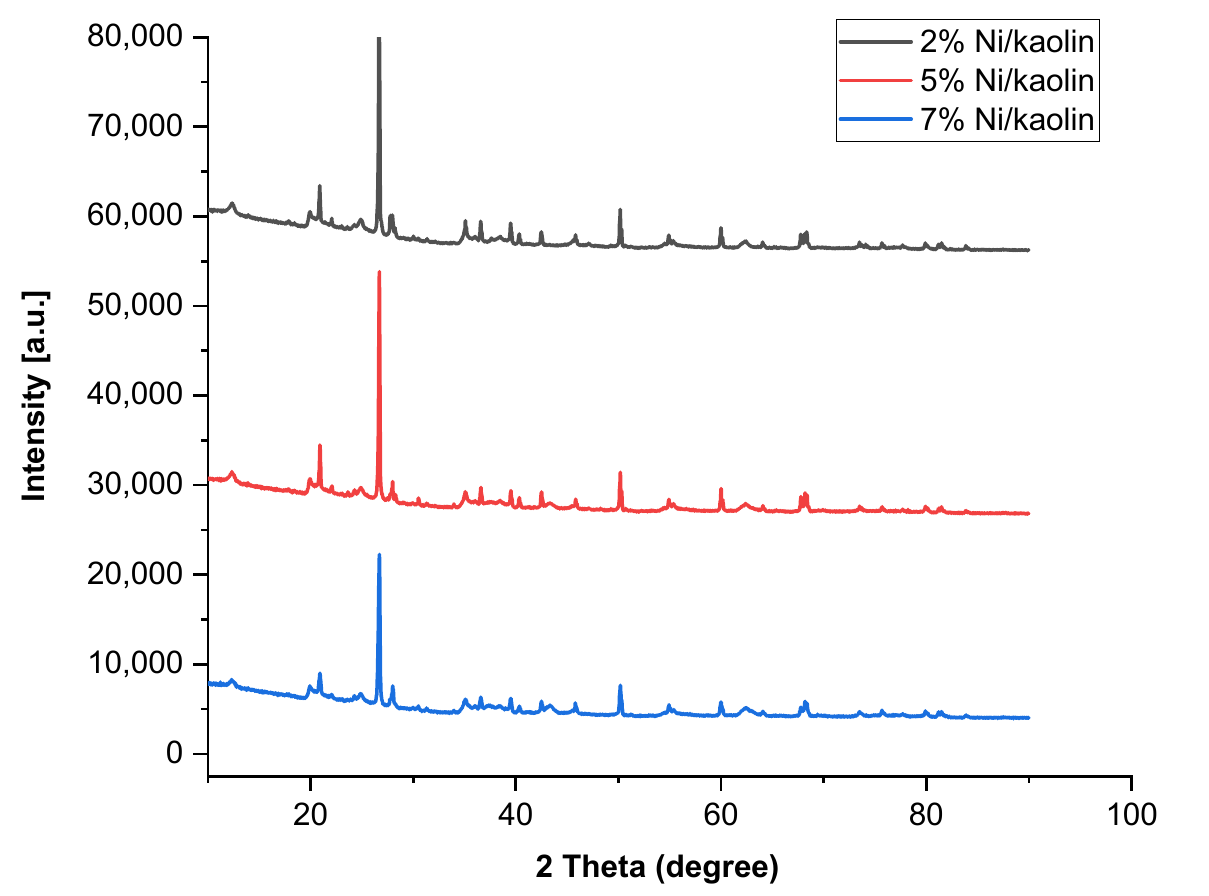
Figure 4. X-ray diffractograms of supported catalysts (2%, 5%, and 7% of Ni/kaolin).